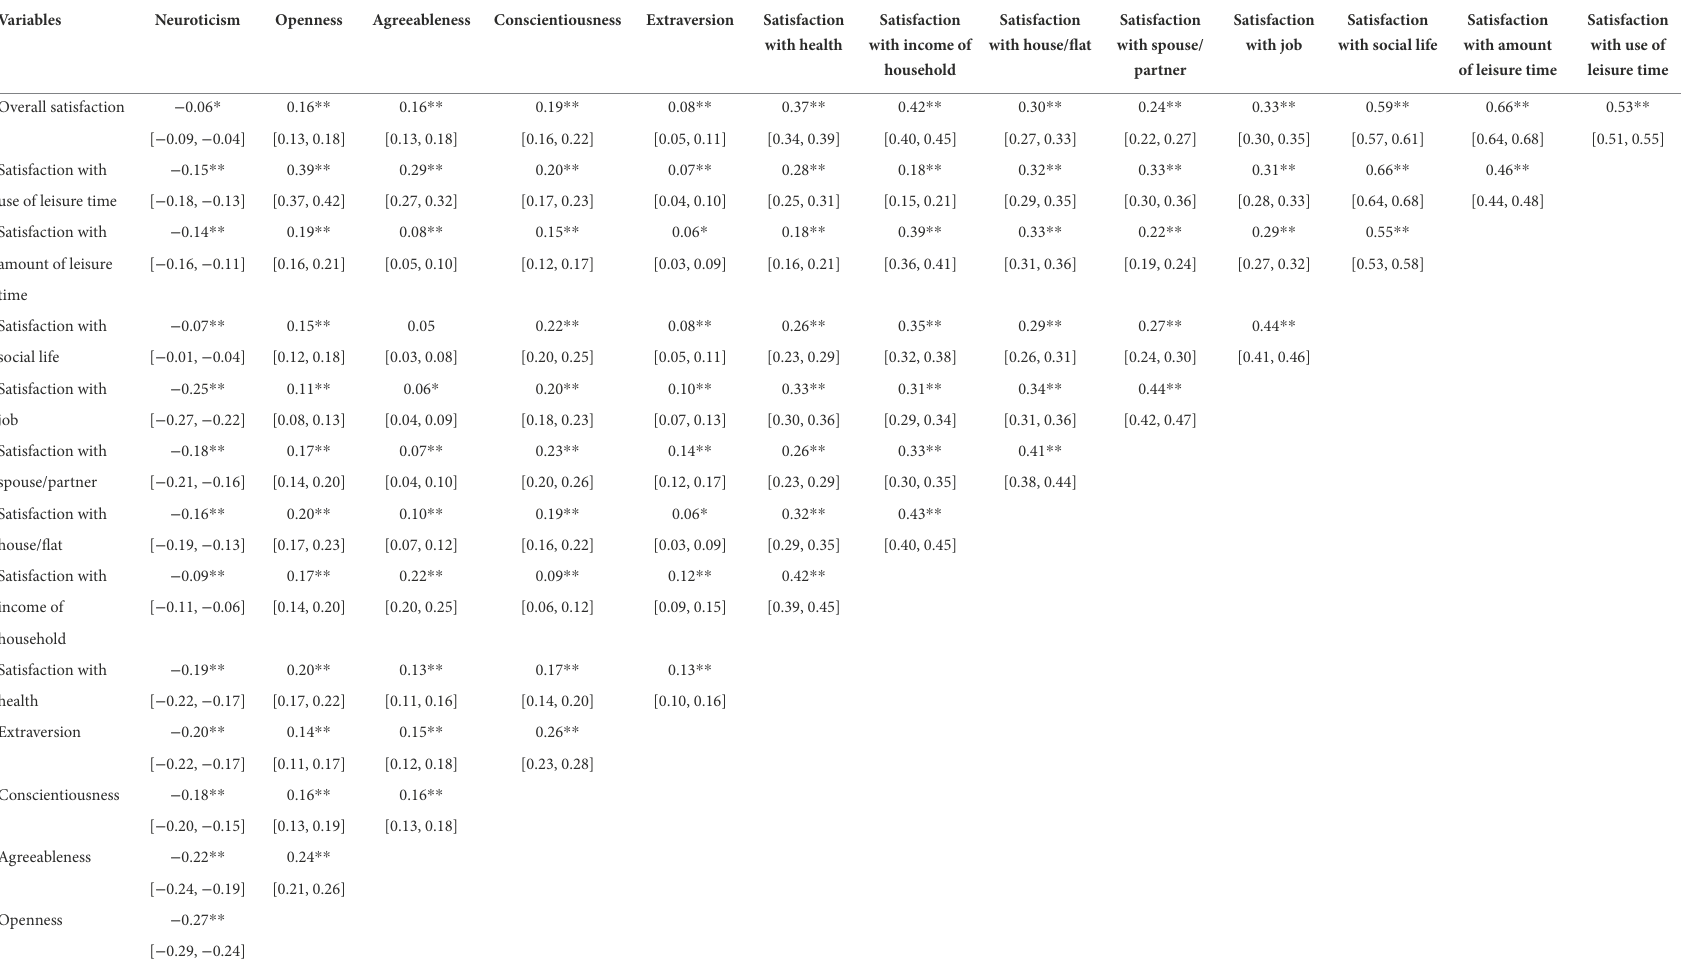
TABLE 6 Correlation between Neuroticism, Openness, Agreeableness, Conscientiousness, Extraversion, satisfaction with health, satisfaction with income of household, satisfaction with house/flat, satisfaction with spouse/partner, satisfaction with job, satisfaction with social life, satisfaction with amount of leisure time, satisfaction with use of leisure time, and overall satisfaction.